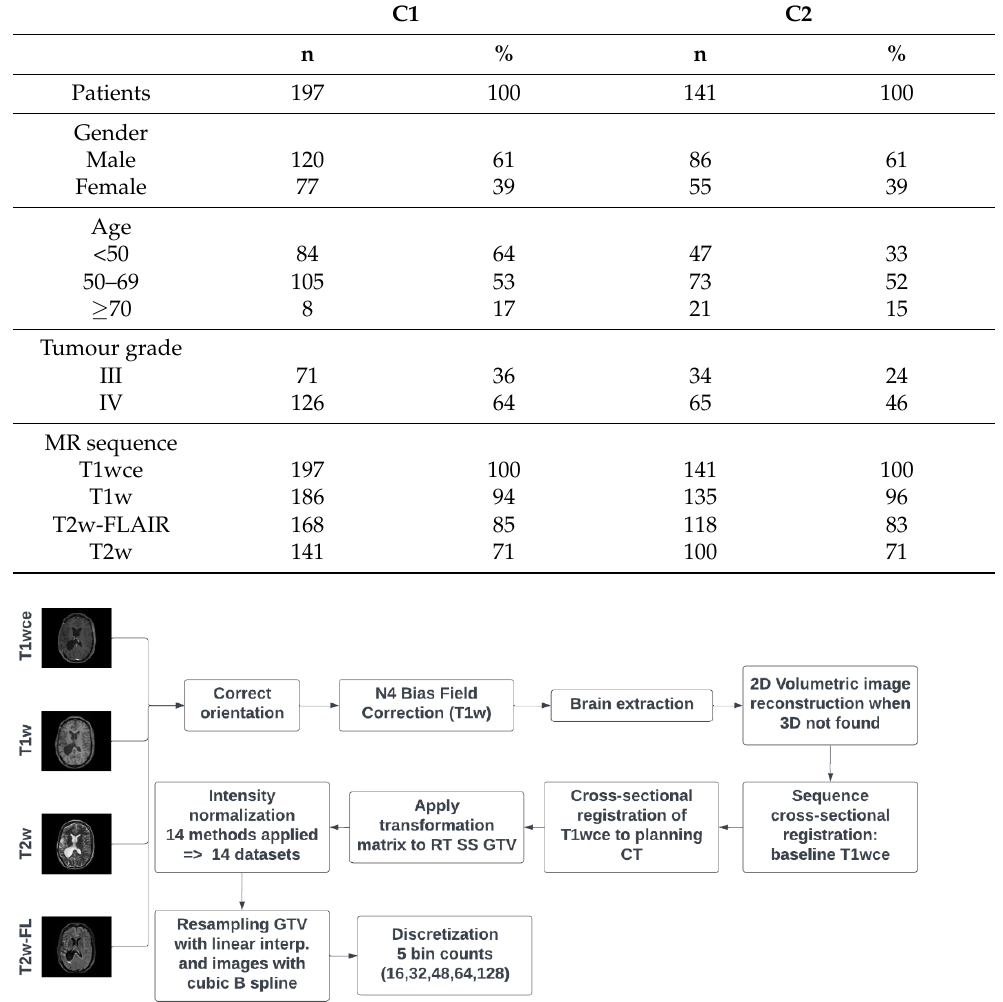
Figure 1. MR preprocessing diagram was applied to both cohorts. RT SS GTV represents the gross tumour volume segmentation extracted from the DICOM RT structure set. T2w-FL: T2w-FLAIR.